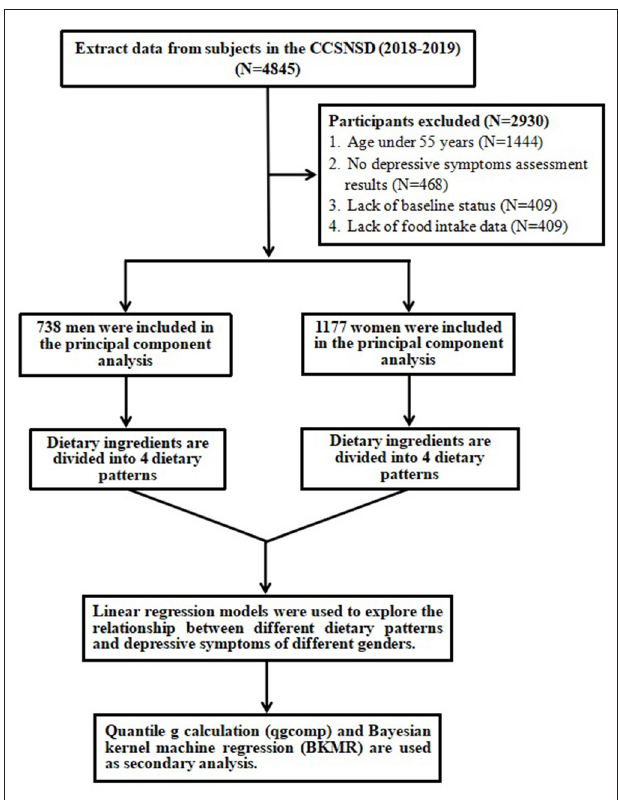
FIGURE 1 | Selection process of